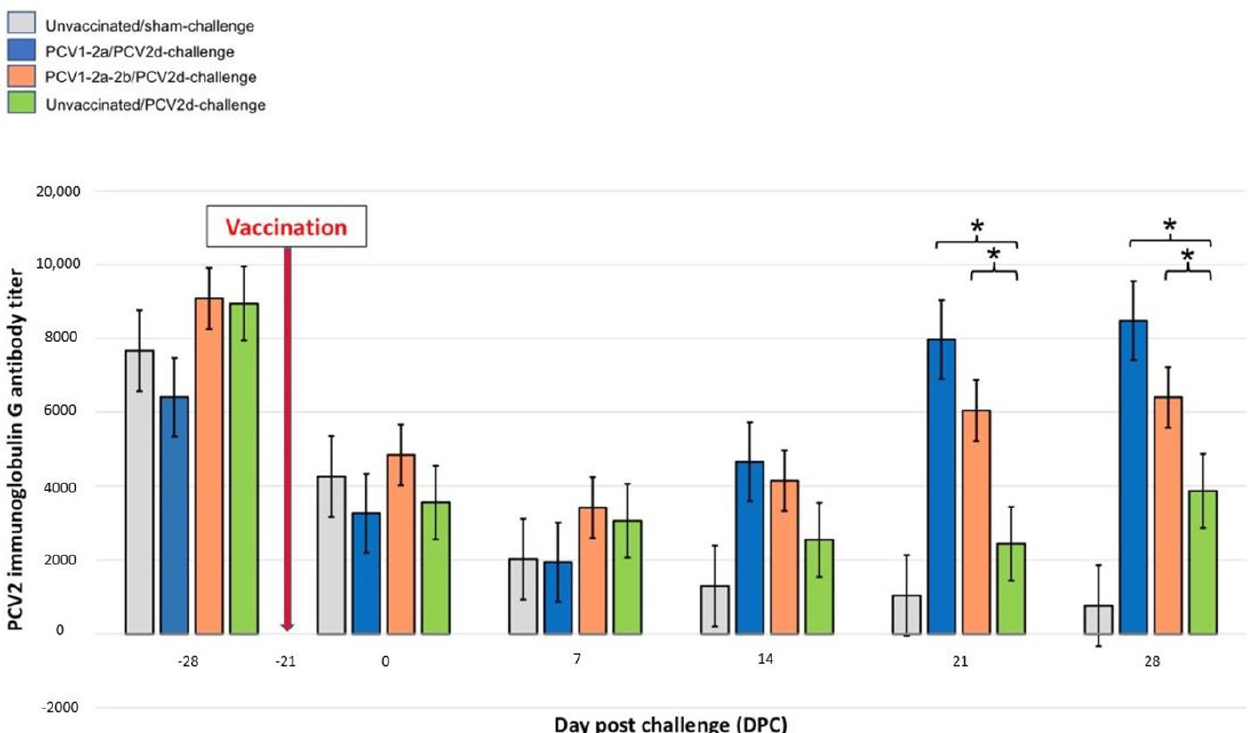
Figure 4. PCV2-immunoglobulin G (IgG) antibody titers of pigs when evaluated by ELISA. Serum samples were found to be positive for anti- PCV2 if the reciprocal ELISA titer was ≥1071. A signifi-